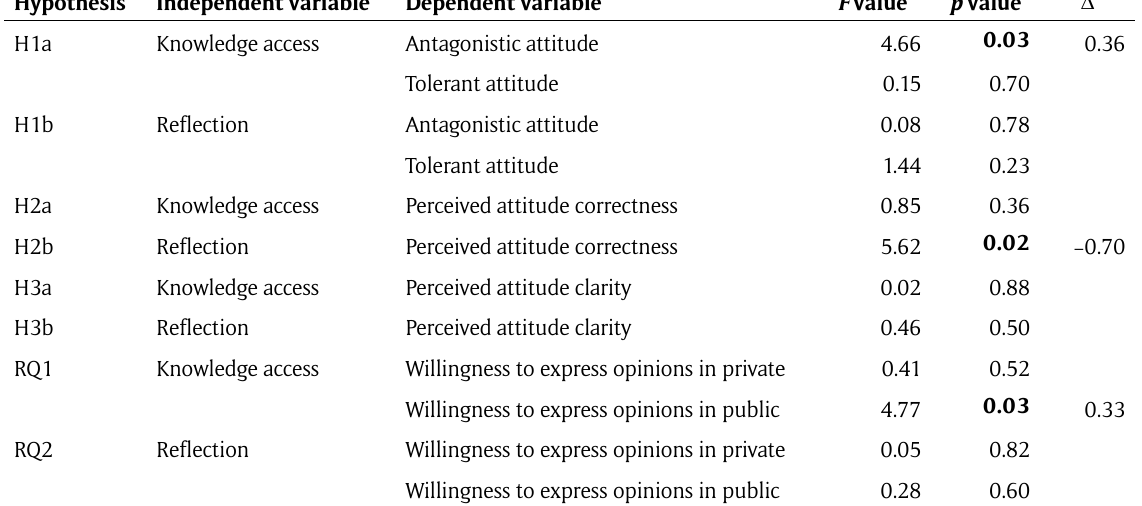
Table 3: Summary for results of hypotheses and research questions.